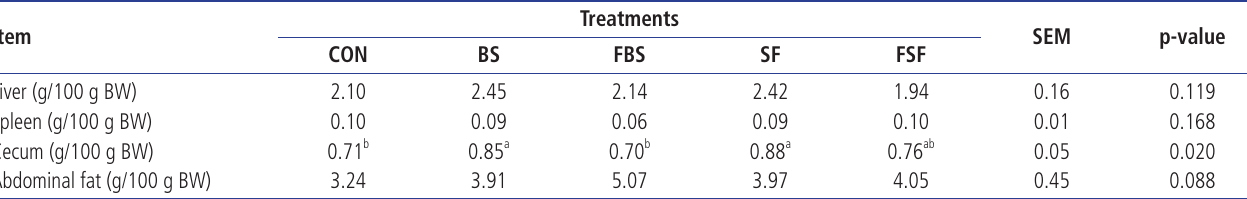
Table 5. Effects of dietary supplementation with non-fermented or fermented by-products of brown seaweed and seaweed fusiforme on relative organ weights in laying hens